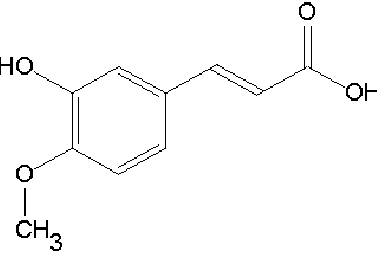
Figure 1. The chemical structure of isoferulic acid (3-hydroxy-4-methoxycinnamic